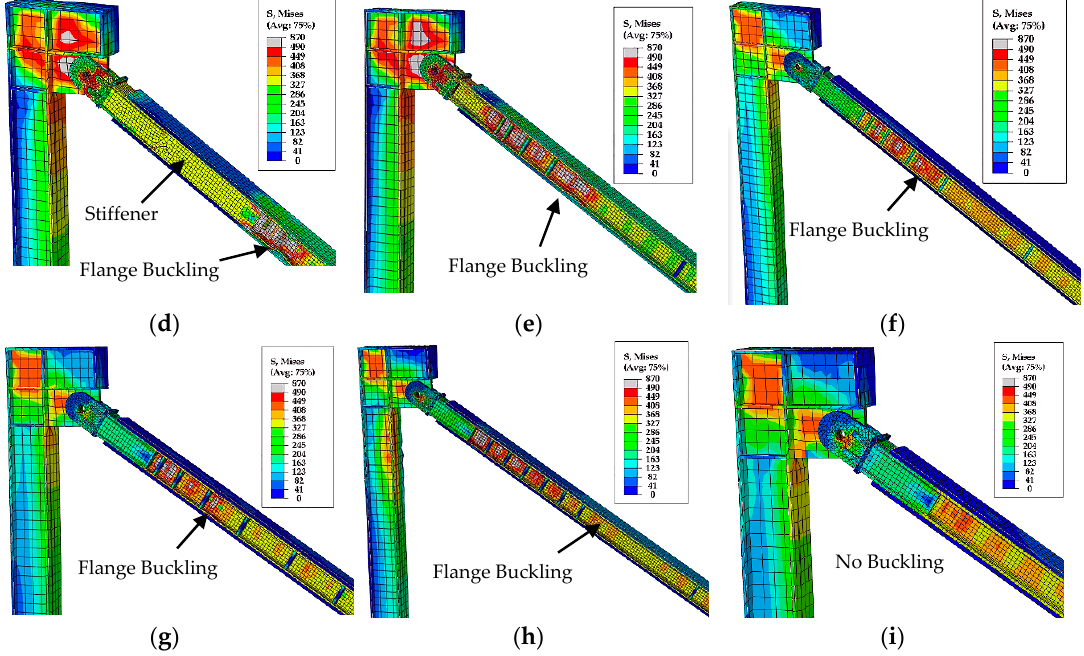
Figure 13. Influence of stiffener details and core flange thickness: ( a ) L340, ( b ) L510, ( c ) L850, ( d ) L1500,